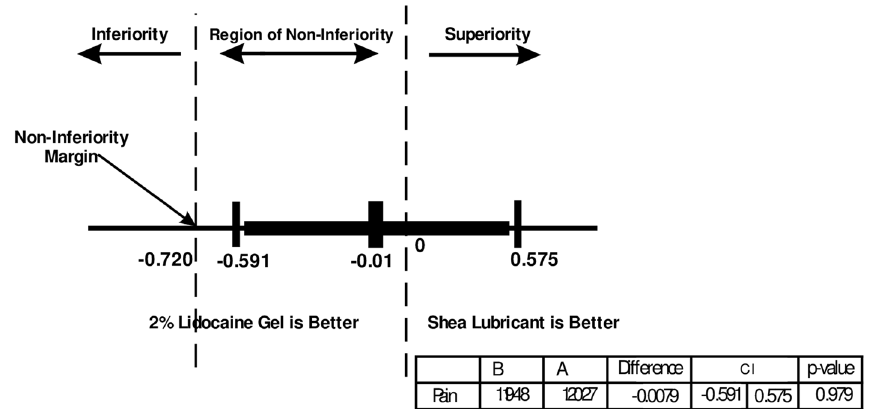
Figure 5. Sensitivity analysis to test primary outcome (intention-to-treat